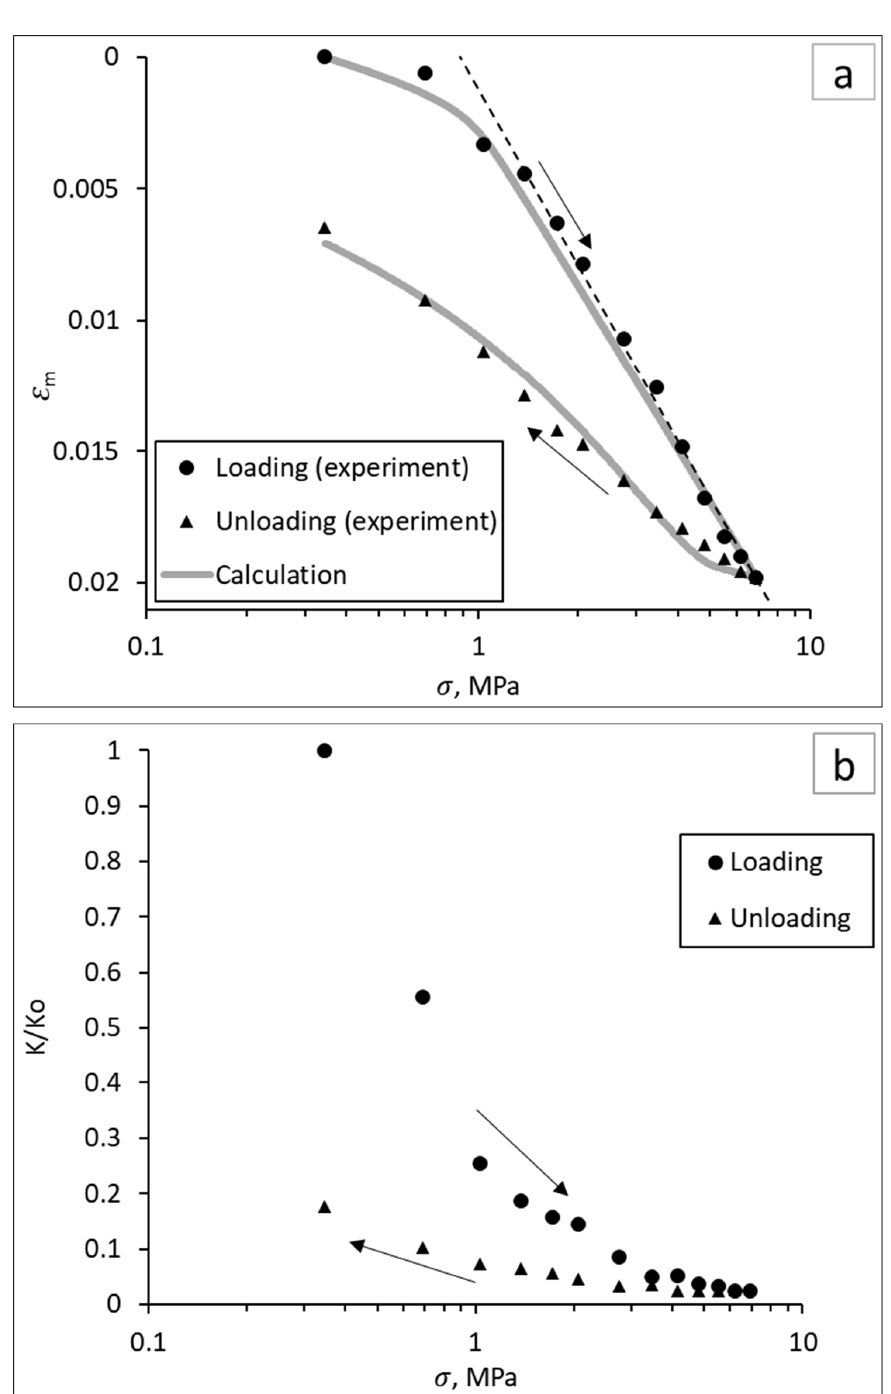
Figure 7. Strain-stress path and permeability in a stress cycles (coal sample 3). 289 Figure 7. Strain–stress path and permeability in a stress cycles (coal sample